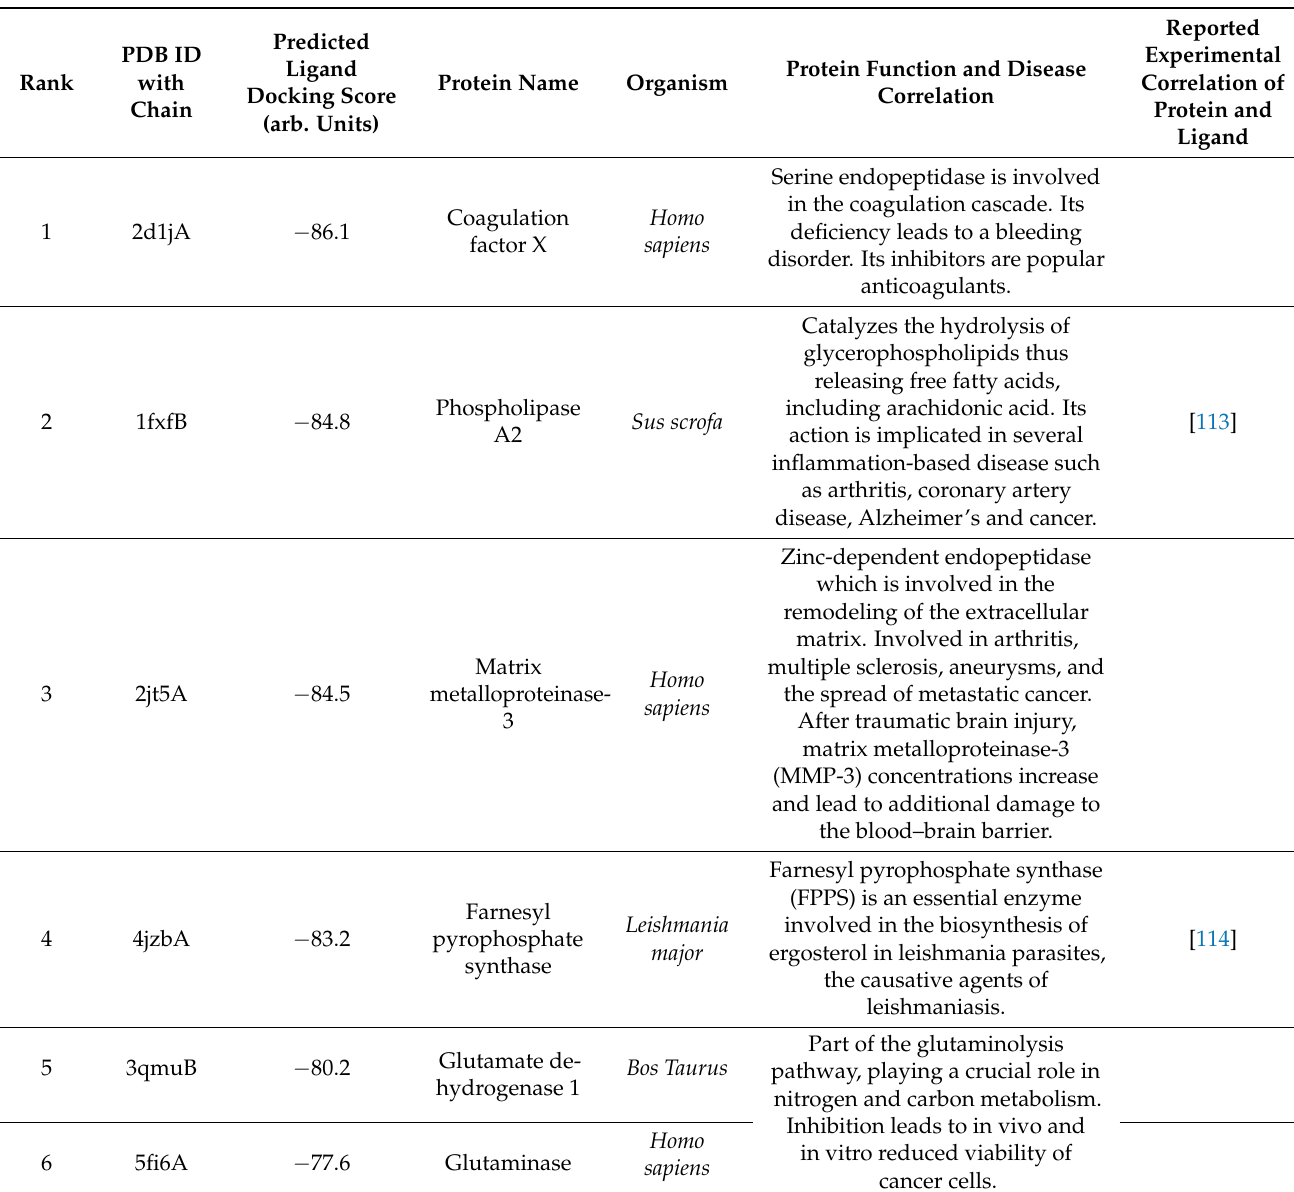
Table 2. Best scoring mammalian, human, and pathogen protein targets of rosmarinic acid. Docking scores independent of the organism or type of protein are collected in Supplementary Materials in Table